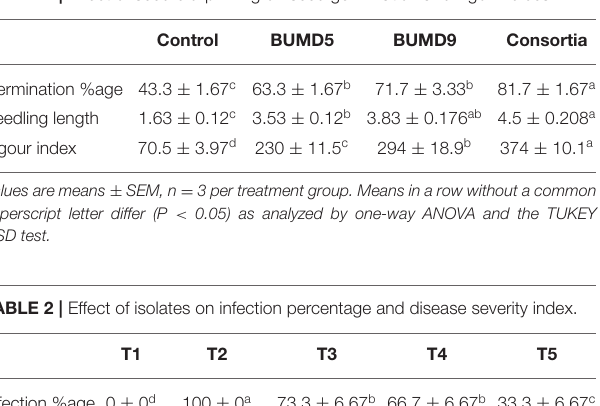
TABLE 1 | Effect of seed bio-priming on seed germination and vigor indices.